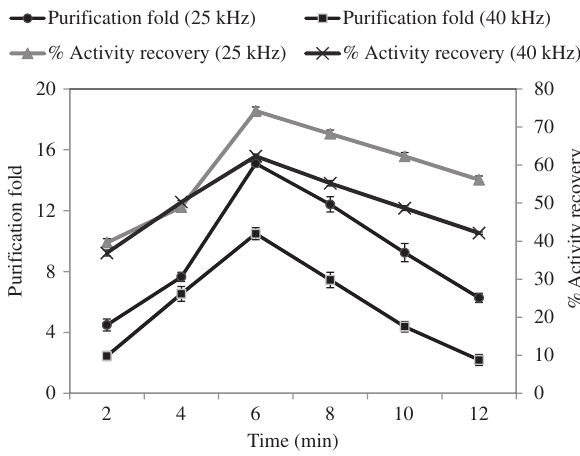
Figure 1: Effect of ultrasonication frequency (25 kHz and 40 kHz) and irradiation time on ultrasound assisted three phase partitioning (UATPP) of